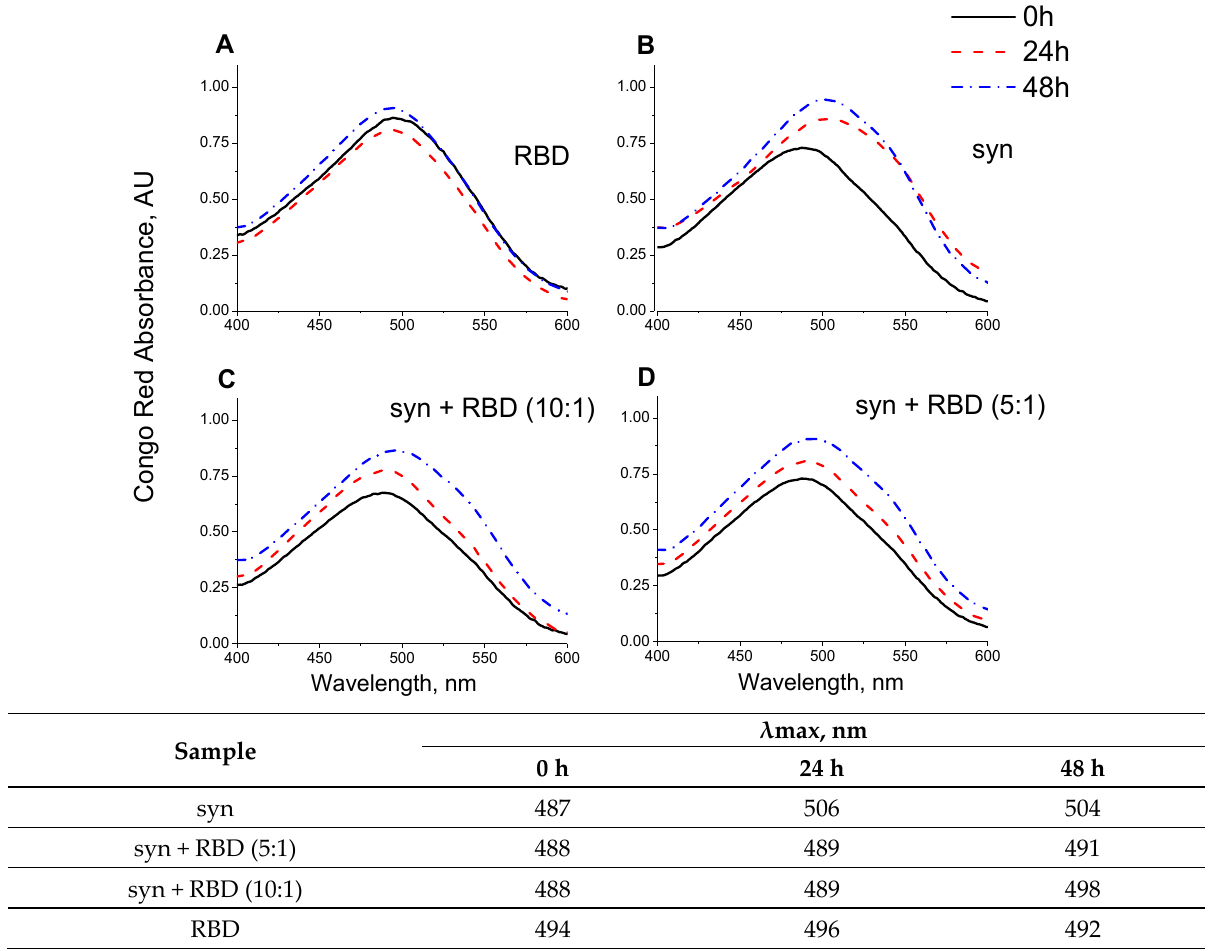
Figure 8. Congo Red absorbance changes of the alpha-synuclein, fibrillized in the presence of SARS- CoV-2 RBD. Congo Red absorbance spectra of SARS-CoV-2 RBD ( A ), 28 µM alpha-synuclein ( B ), 28 µM alpha-synuclein and 5.6 µM SARS-CoV-2 RBD (molar ratio 5:1, ( C )), 28 µM alpha-synuclein and 2.8 µM SARS-CoV-2 RBD (molar ratio 10:1, ( D )) for 0 h (solid line), 24 h (dashed line), and 48 h (dash-dotted line).